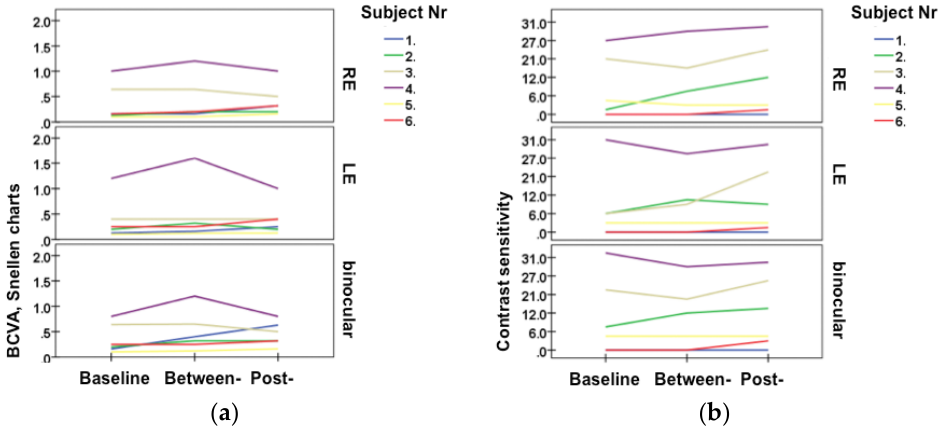
Figure 2. Line diagrams representing the individual patient’s examination data (presented separately for the RE: right eye; for the LE: left eye and for both eyes: binocular); ( a ) BCVA, Snellen charts; ( b ) Contrast sensitivity. The acupuncture effect was analyzed at the beginning (1: baseline-), after five acupuncture sessions (2: between) and at the end of the acupuncture treatment (3: post-).